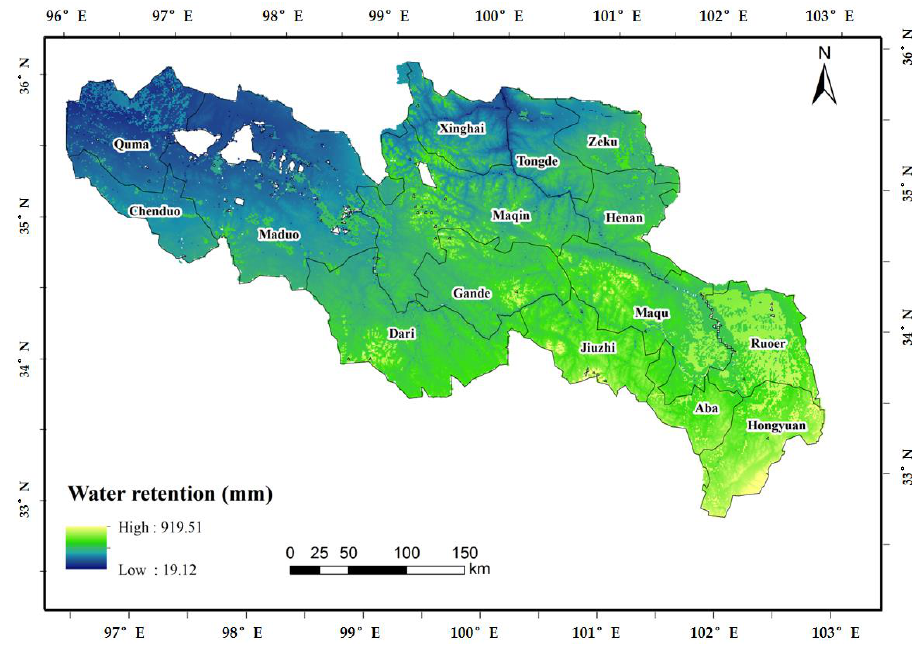
Figure 2. Spatial distribution of water retention mean value in the HYR.